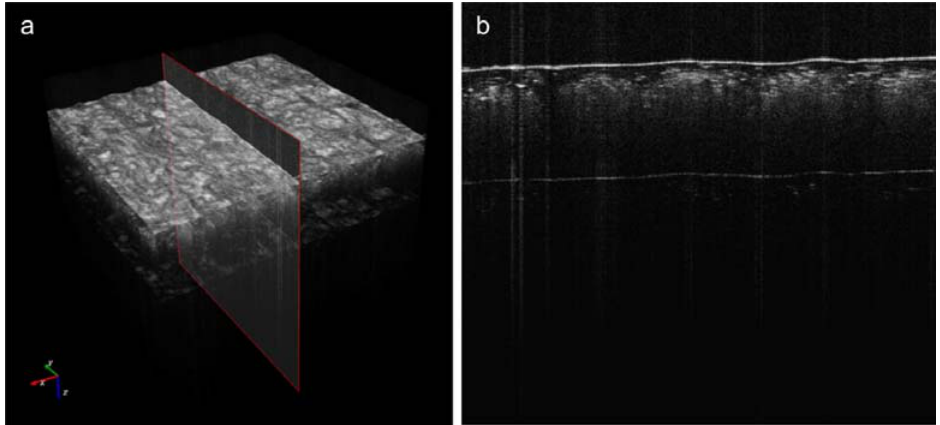
Figure 11. Example OCT C ‐ scan of a Cordura 4 (Camouflage, bottom rows of Figures 2 and 5) sample region R ( a ) with selected B ‐ scan in the YZ ‐ plane ( b ).